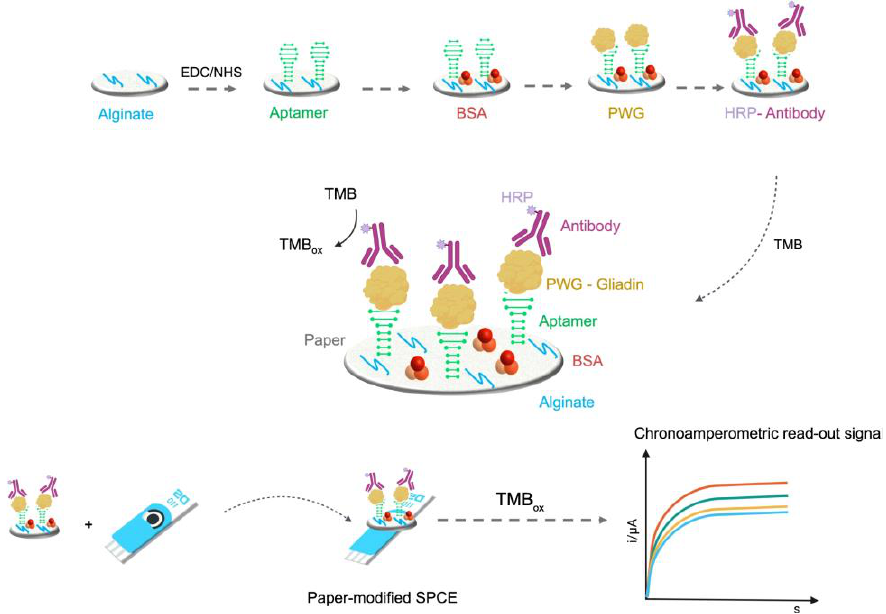
Figure 11. Schematic representation of the gluten paper-based biosensor design and working principle. Reprinted from [137].